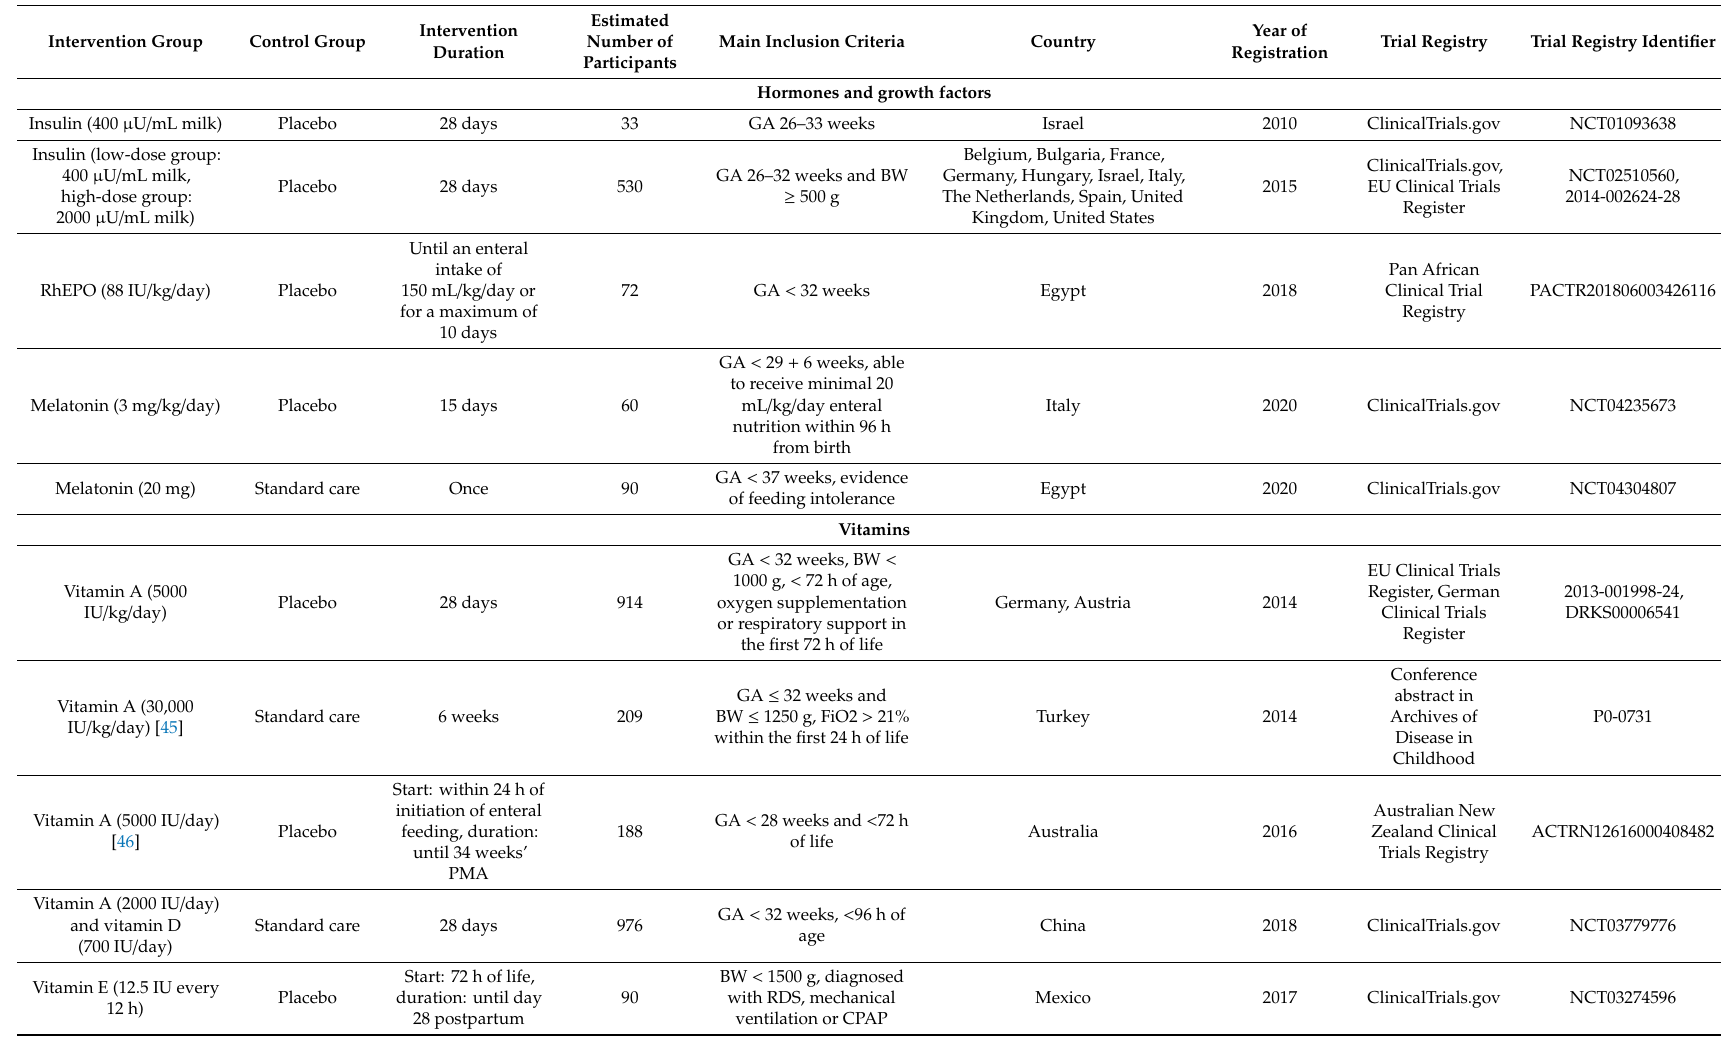
Table 3. Overview of ongoing or recently completed trials investigating the e ff ect of a supplemental enteral bioactive factor in preterm